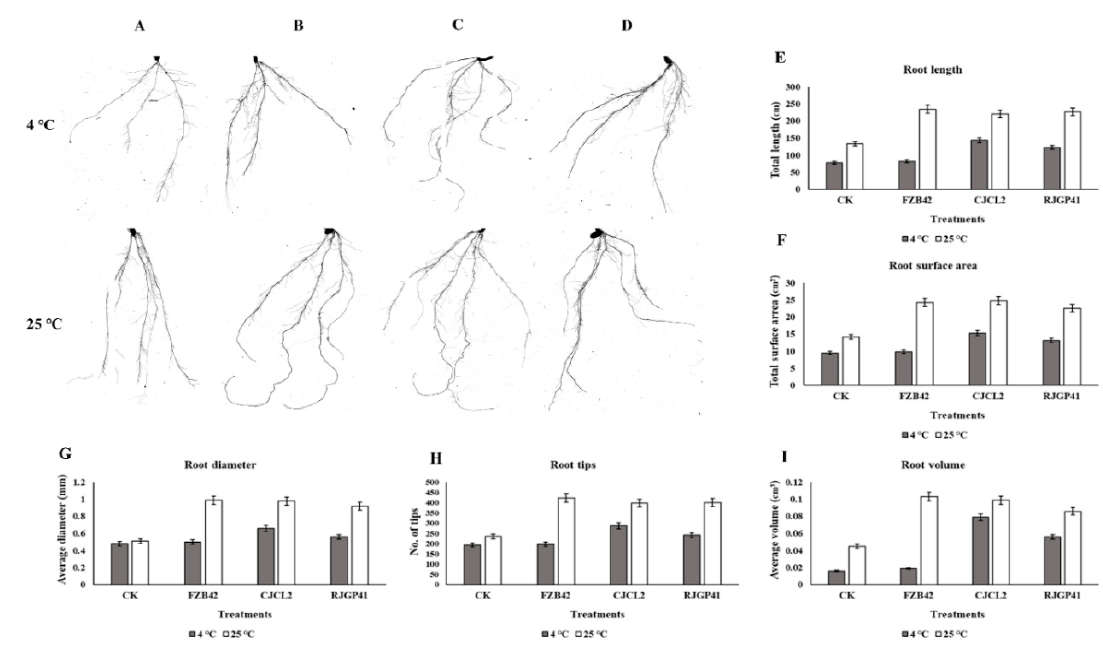
Figure 12. The rhizoscanning image of roots of un-inoculated wheat plants grown at 4 °C and 25 °C ( A ), The rhizoscanning image of roots treated with FZB42 ( B ), The rhizoscanning image of roots treated with CJCL2 ( C ), The rhizoscanning image of roots treated with RJGP41 ( D ) Root morphology parameters such as Total root length (cm) of wheat plants inoculated with selected bacterial strains and grown at 4 and 25 °C ( E ), The total surface area (cm 2 ) of roots of wheat ( F ), the diameter of the roots (mm) ( G ), number of root tips for each treatment ( H ) the total root volume (cm 3 ) ( I ) are comparatively represented by graphs. The error bars shown on the graphs represent standard deviation of the mean ( n = 5). The significance among different treatments was observed at p ≤ 0.05 by using Tukey’s HSD test. The experiment was performed in triplicate with similar results.